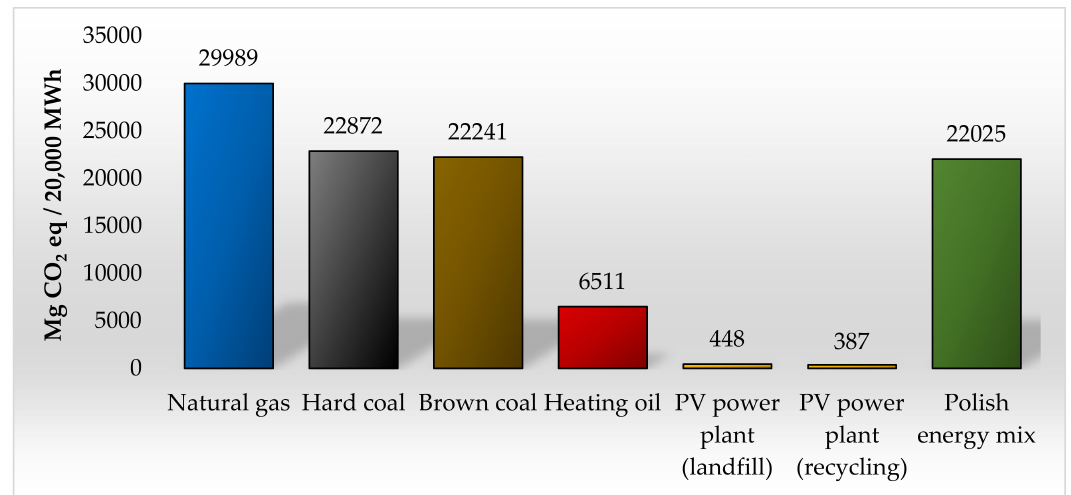
Figure 10. The results of the characterization of the environmental after-e ff ects in relation to cumulated greenhouse gas (GHG) emissions arising from the production of 20,000 MWh of electricity from selected energy sources [unit: